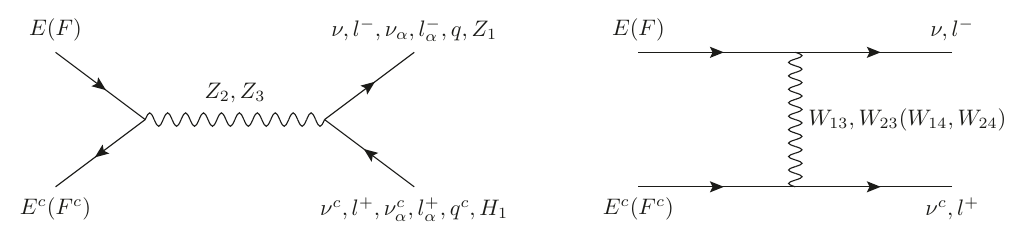
Figure 2 . Dominant contributions to annihilation of the two-component fermion dark matter into standard model